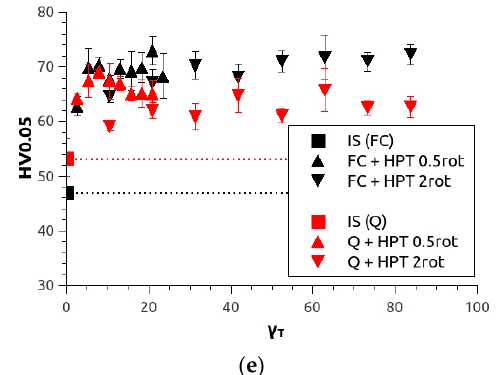
Figure 7. Microhardness results for ( a ) Mg5Zn0.3Ca, ( b ) Mg5Zn, ( c ) Mg5Zn0.15Ca, ( d ) Mg5Zn0.15Ca0.15Zr and ( e ) Mg0.3Ca in the initial state (IS–dotted line) after furnace-cooling (FC, black) and quenching (Q, red) and additional HPT deformation at room temperature at 4 GPa, 0.5 and 2 rotations giving torsional strains up to γ T